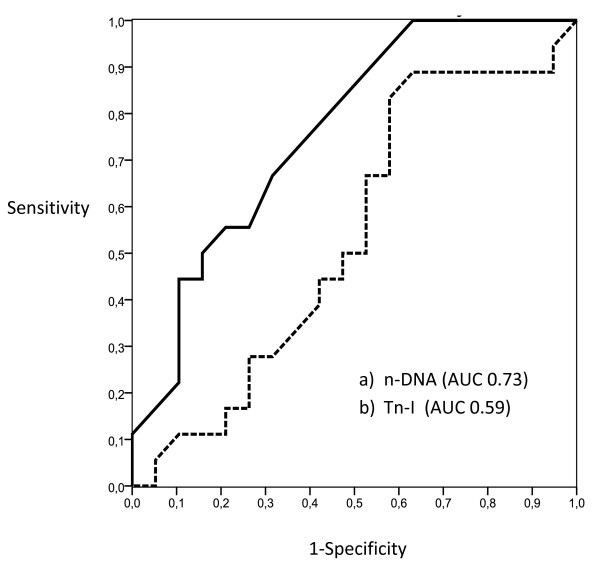
ROC curves for the use of plasma n-DNA and Tn-I, to predict 15-day mortality. The best cut-offs were 3,625 GE/ml for n-DNA, and 0.020 ng/ml for Tn-I, based on the calculated AUCs of 0.73 (95% CI, 0.60 to 0.91) and 0.599 (95% CI, 0.41 to 0.79), respectively.